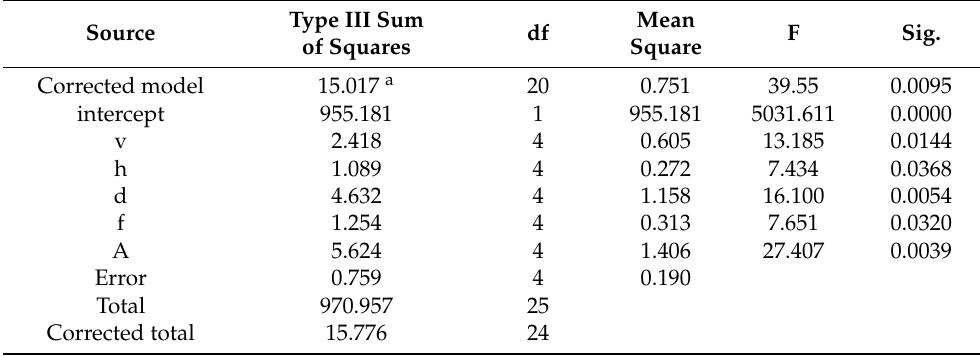
Table 11. Analysis of variance for orthogonal